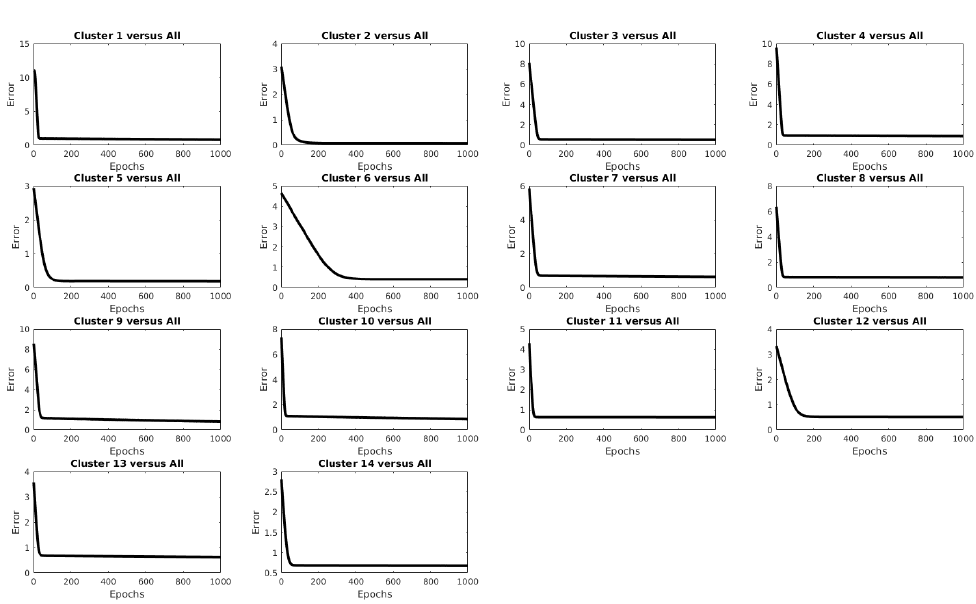
Figure 5. Error versus epoch curve of each one-versus-all case for the Botswana image.